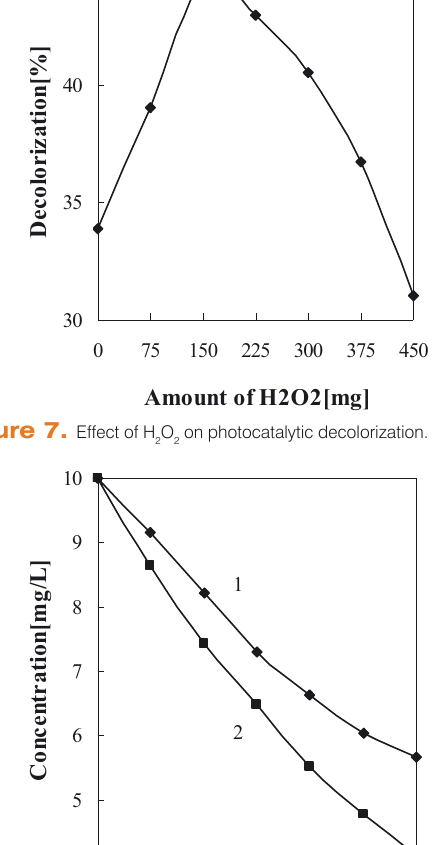
Figure 8. The promotion effect of hydrogen peroxide on the photo- catalytic decolorization (1)KPS (2) KPS+H